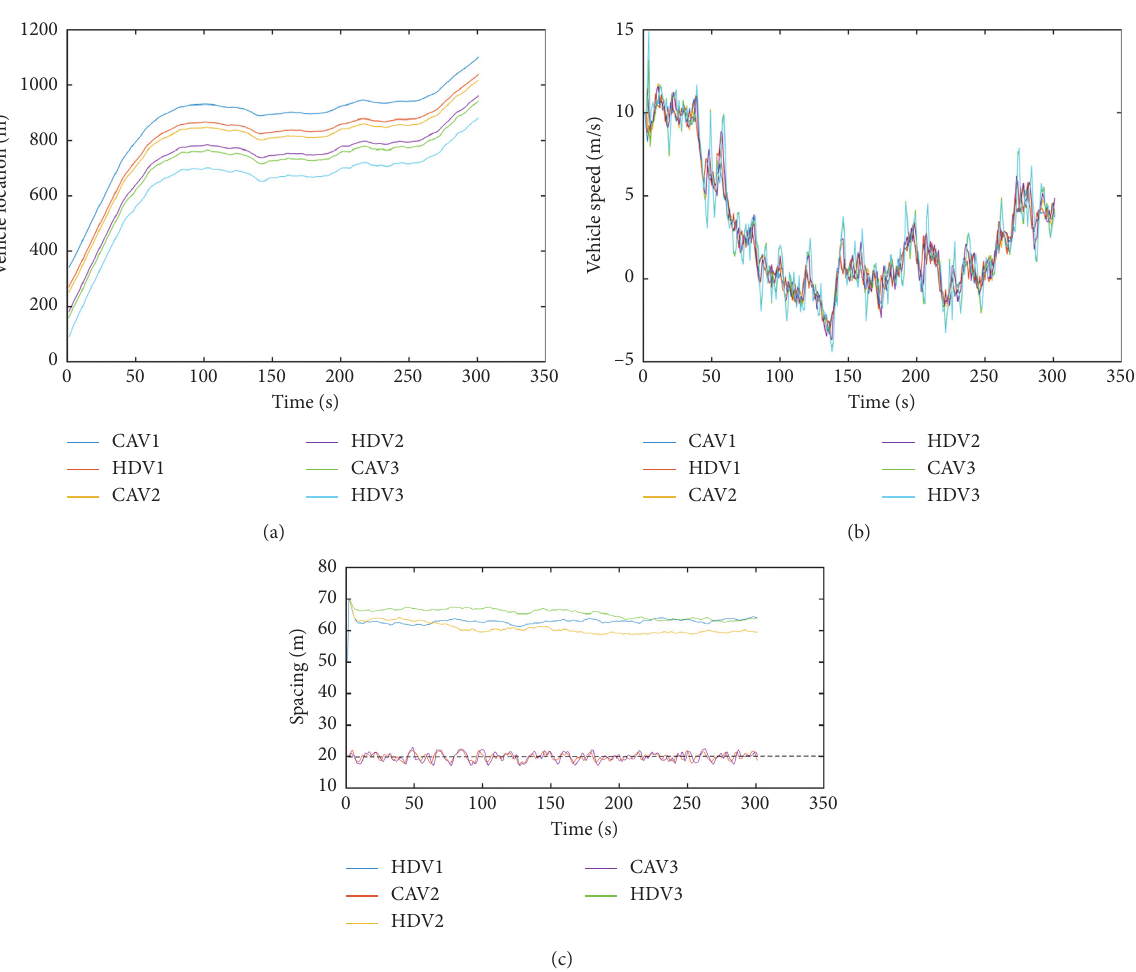
Figure 7: The fleet in dense fog environment with the visibility being 70m. (a) The location of formation. (b) The speed of formation. (c) The spacing of